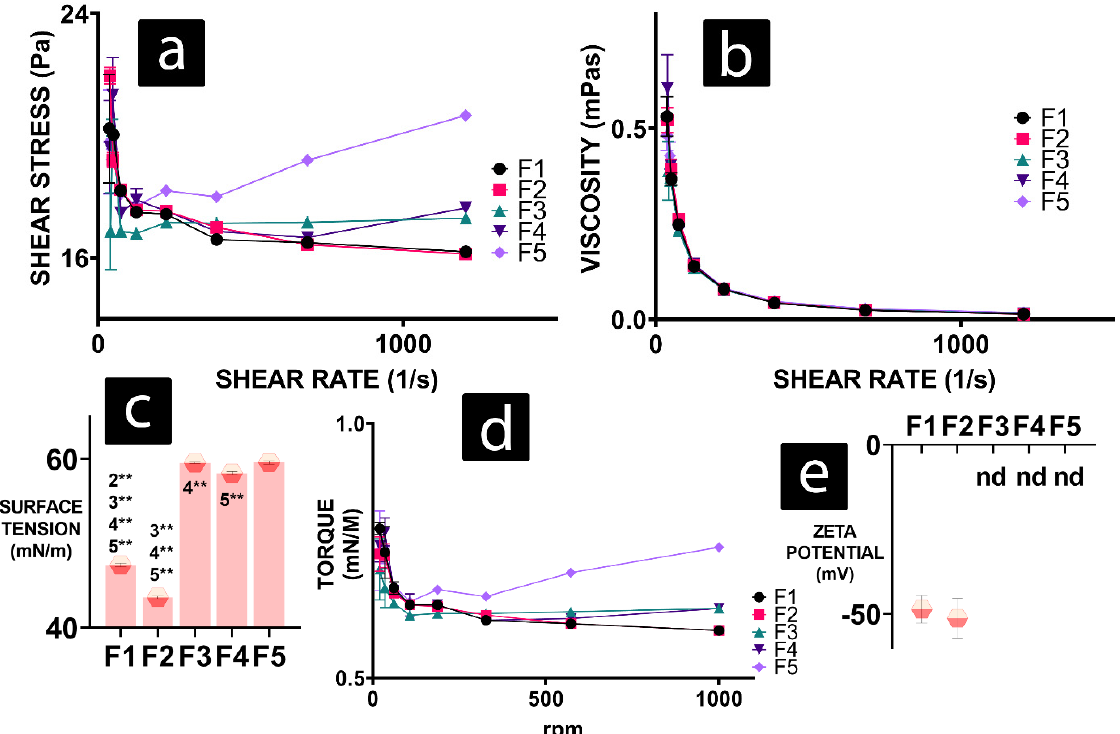
Figure 1. Rheology results of F1 to F5 formulations presented as values of ( a ) shear stress, ( b ) viscosity, ( c ) surface tension, ( d ) torque, and ( e ) zeta potential. p < 0.01 (*) or p < 0.05 (**).